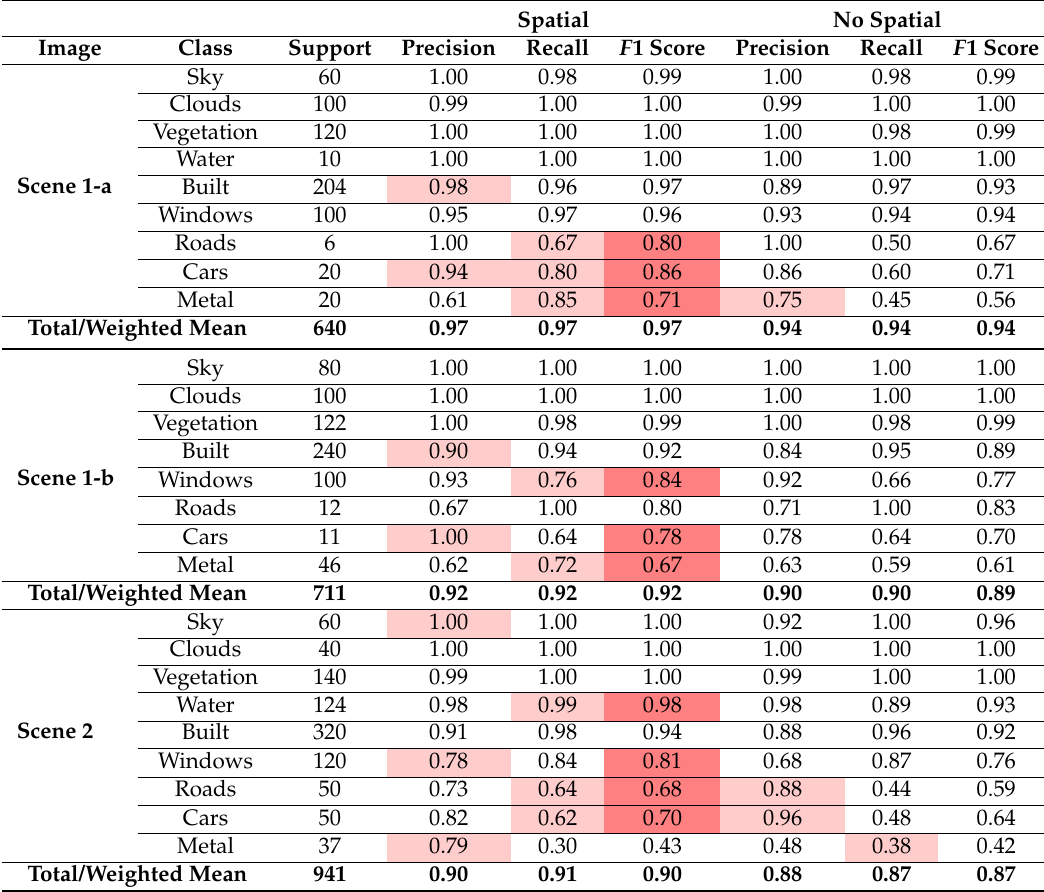
Table 2. Performance metrics of CNN Model 2 both with and without pixel spatial information included for each of the three scenes in Figure 1, computed from the confusion matrices provided in Appendix A Figure A2. The cell highlighting is described in Table 1. Overall, the model variant with spatial information included outperformed that without when classifying the pixels in each scene. Both model variants performed better at classifying Scene 1-a than Scenes 1-b and 2. In particular, the model variant with spatial information included performed better at classifying the human-built structures in each scene, while both model variants had comparable performance in classifying the natural